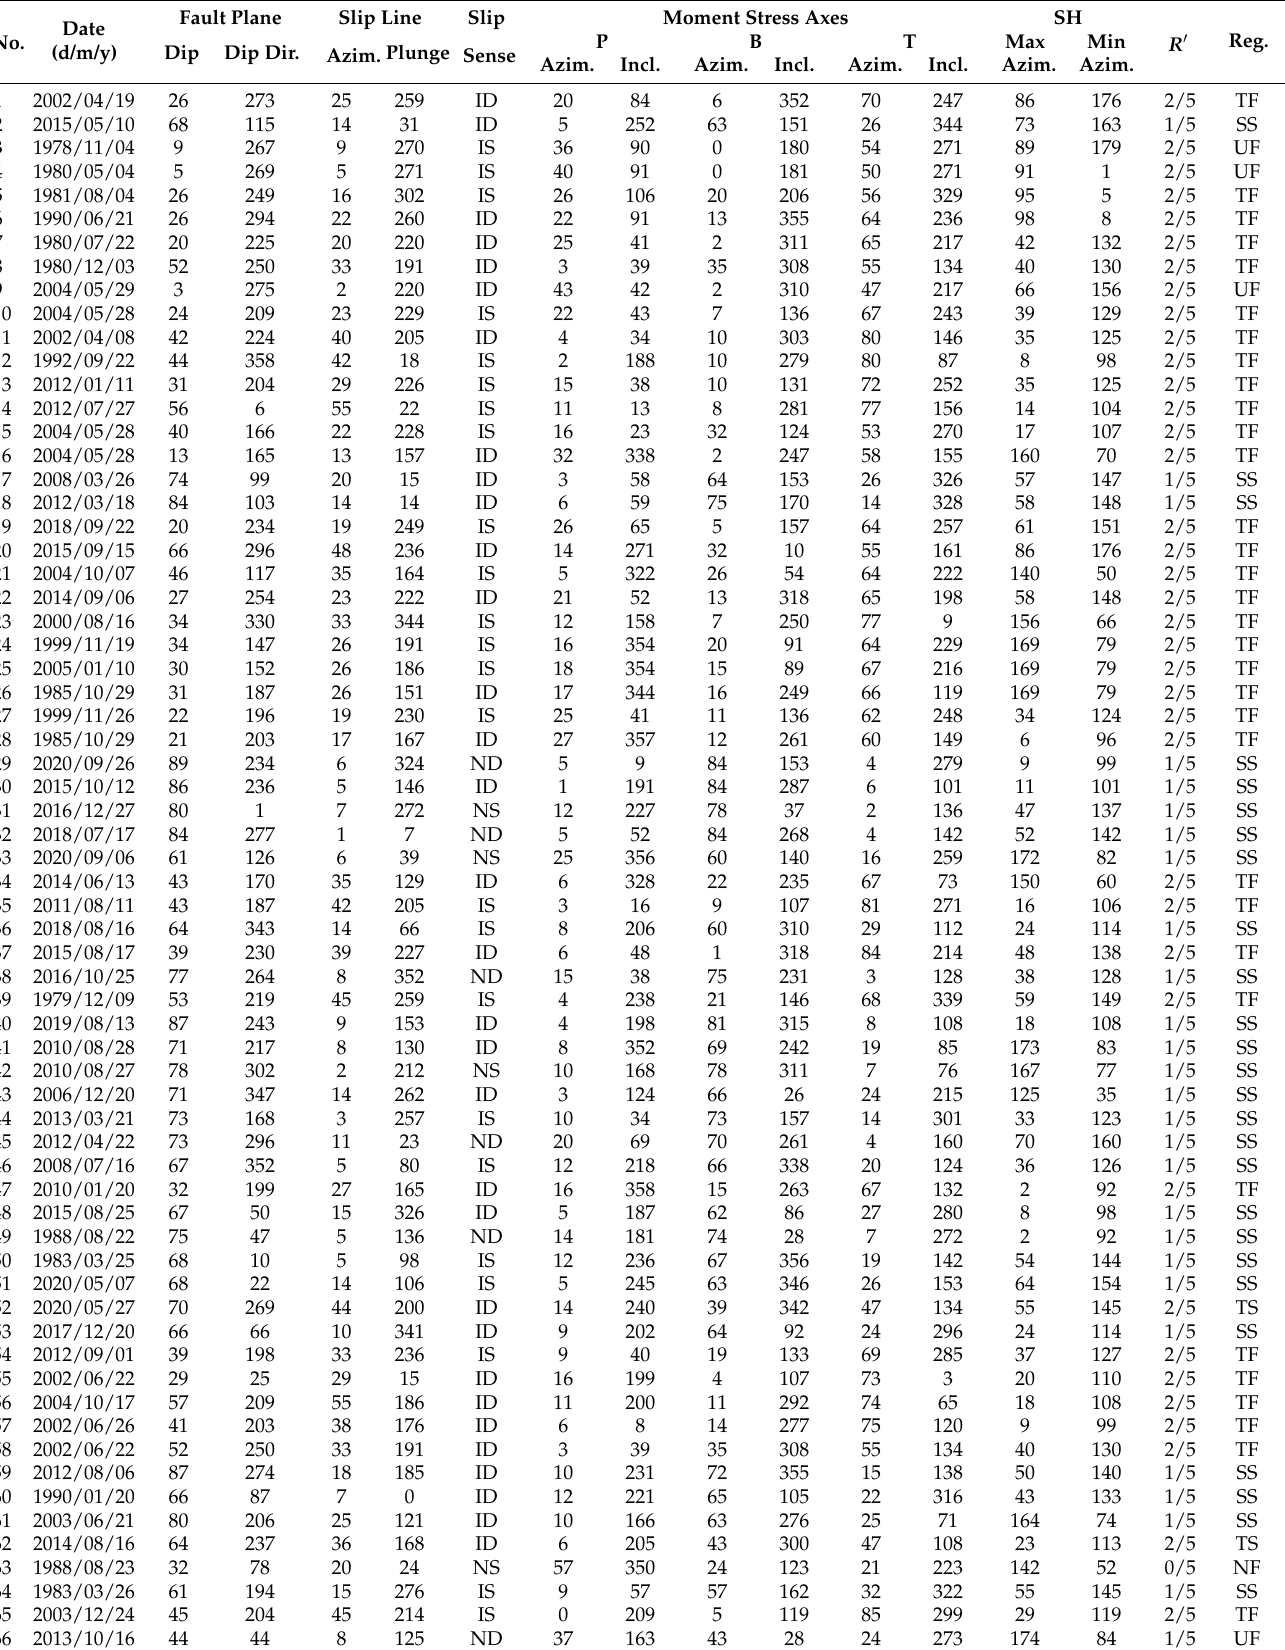
Table 2. The calculated parameters from the stress tensor of the earthquake focal